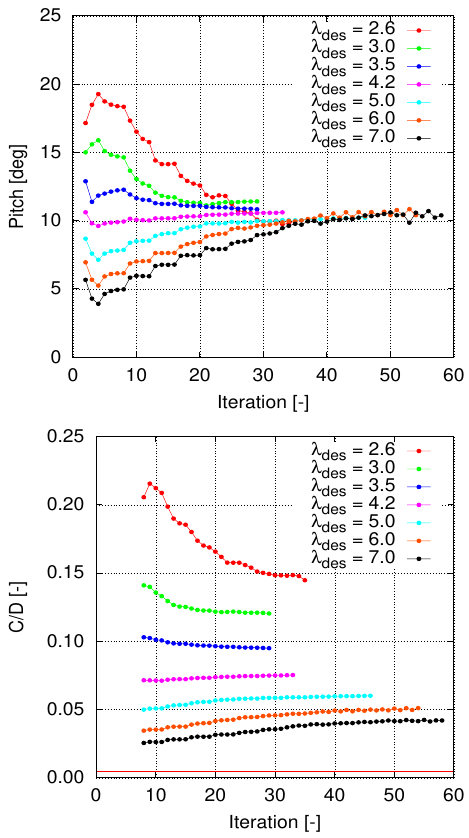
Fig. 16. Model turbine: convergence history of pitch angle β (top) and chord length c/D (bottom), at r/R = 0 . 7 ; λ des values from 2.6 to 7.0.